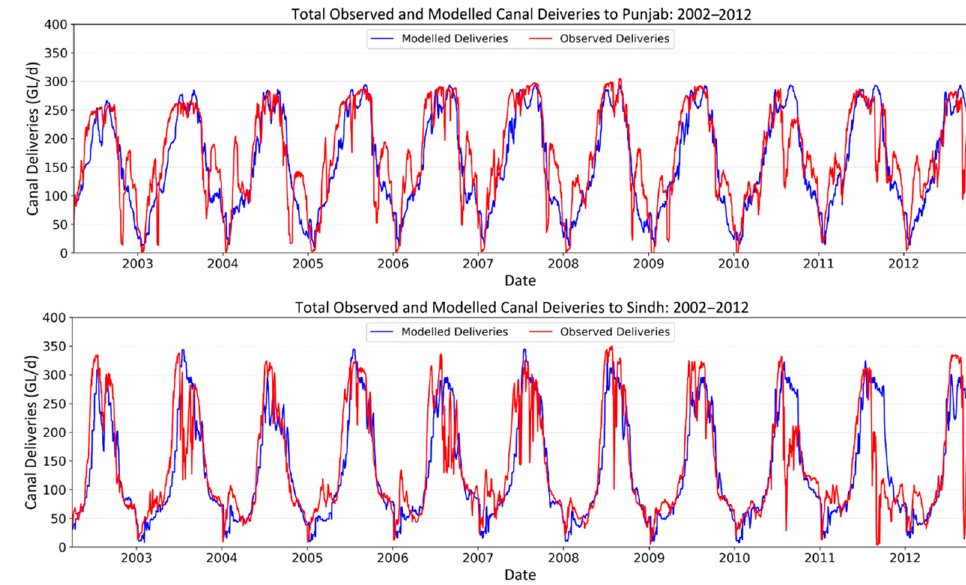
Figure 12. Total observed and modelled canal withdrawals, 2002–2012.